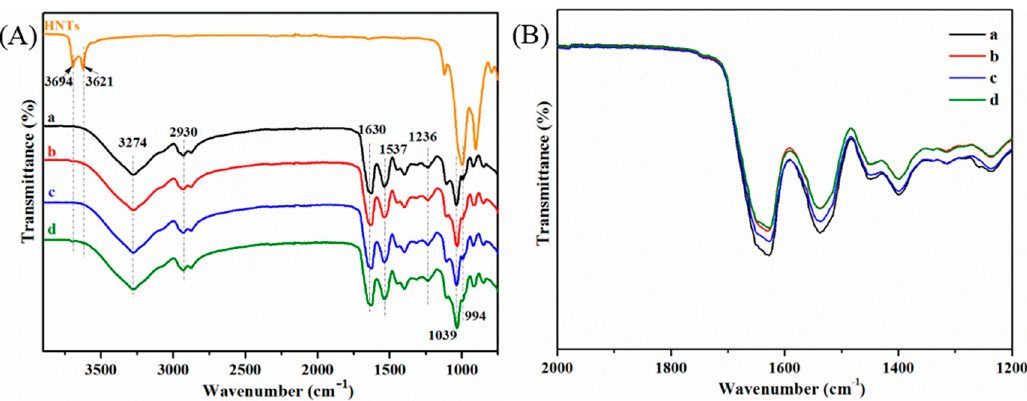
Figure 2. Attenuated total reflectance-Fourier transform infrared (ATR-FTIR) spectroscopy ( A ) of HNTs and SPI-based films: SPI and PTGE film a ; SPI, PTGE, and HNTs film b ; SPI, PTGE, and CMCS film c ; SPI, PTGE, HNTs, and CMCS film d ; magnified image ( B ) of Figure 2A from 2000 to 1200 cm − 1 .